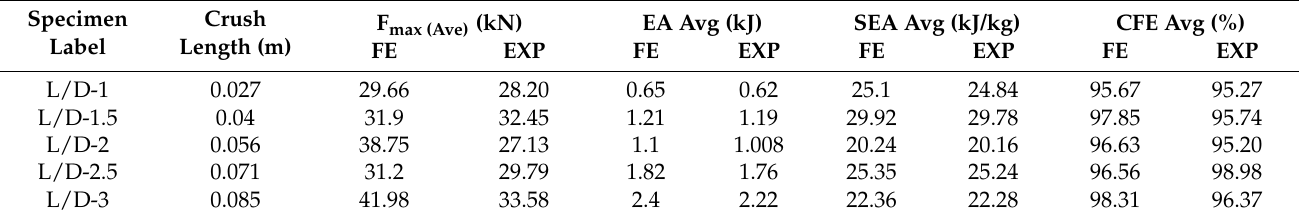
Table 3. The crashworthiness indicators of test specimens with various aspect ratios.